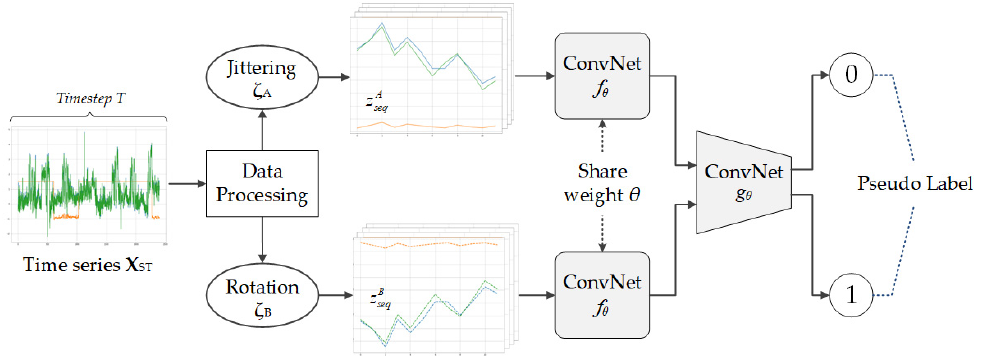
Figure 4. Our proposed SSL paradigm for time ‐ series data .